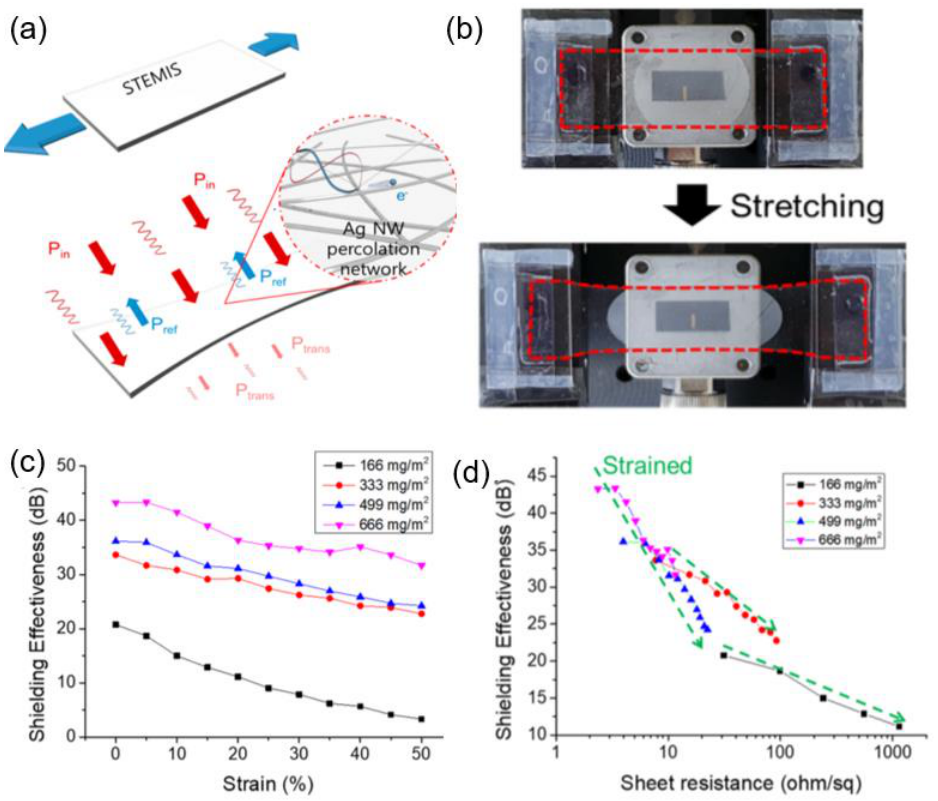
Figure 24. Stretchable and transparent EMI shielding (STEMIS) films based on Ag NW network and their EMI shielding effectiveness under stretching. ( a ) Schematic diagram of STEMIS film of Ag NW network on PDMS film. ( b ) Digital images of EMI shielding test under stretching condition. ( c ) Shielding effectiveness vs. strain (%). ( d ) Shielding effectiveness change vs. sheet resistance. Reproduced with permission from [111]. Copyright 2017 American Chemical Society.